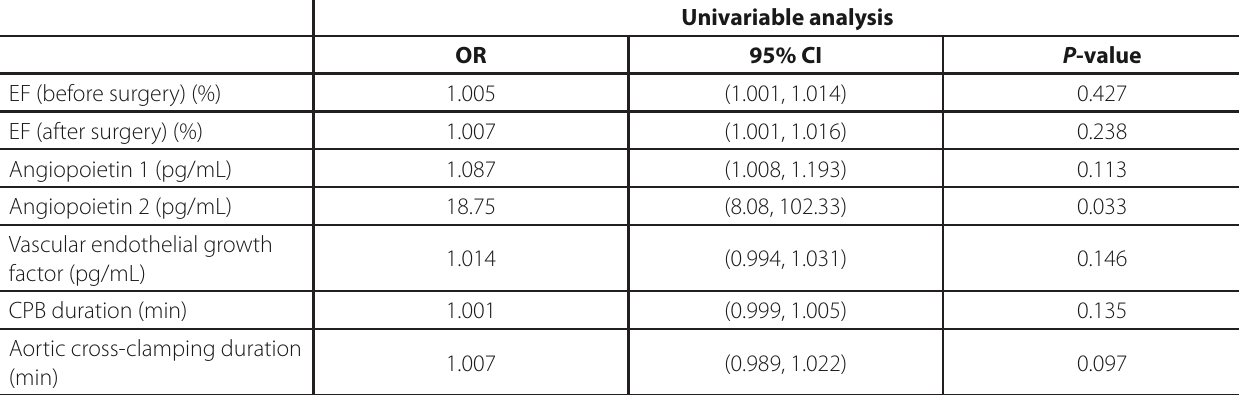
Table 4. Univariable logistic regression.